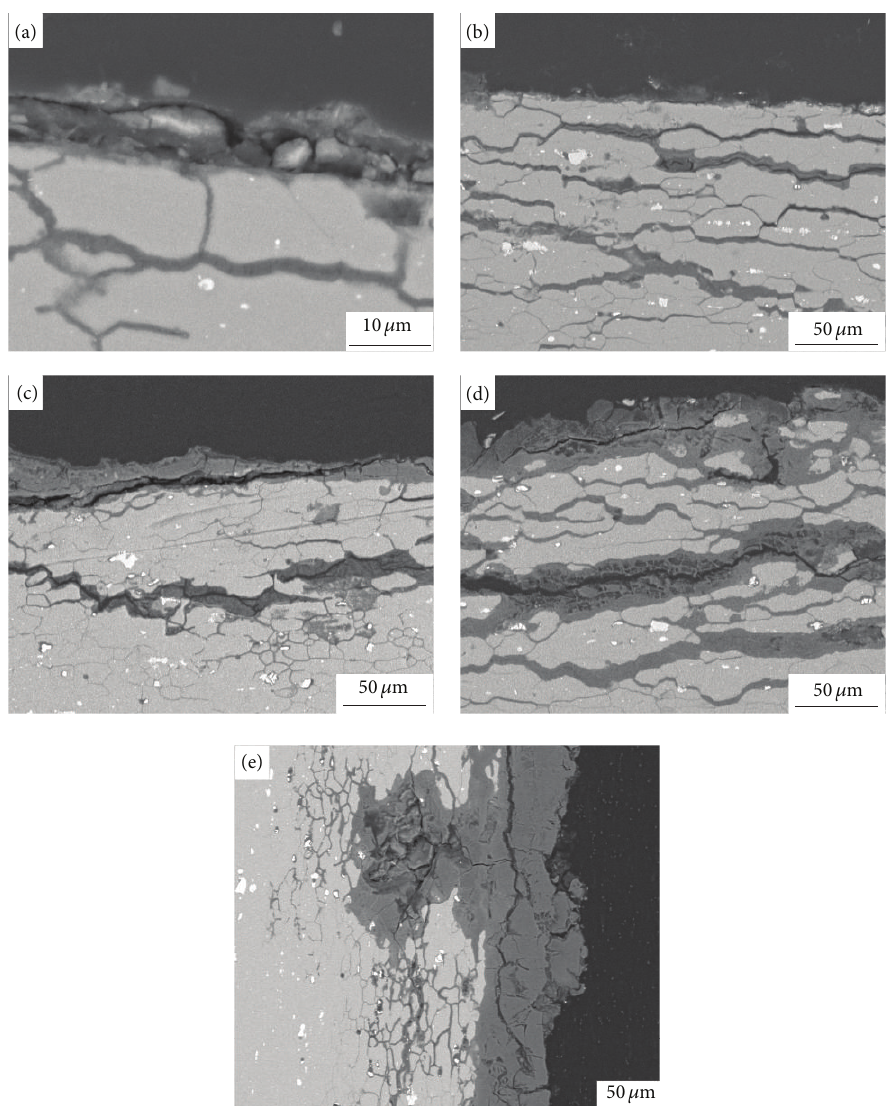
Figure 8: Cross-sectional morphology of 2A12 aluminum alloy after exposure for 1 month (a), 6 months (b), 12 months (c), 24 months (d), and 48 months (e).